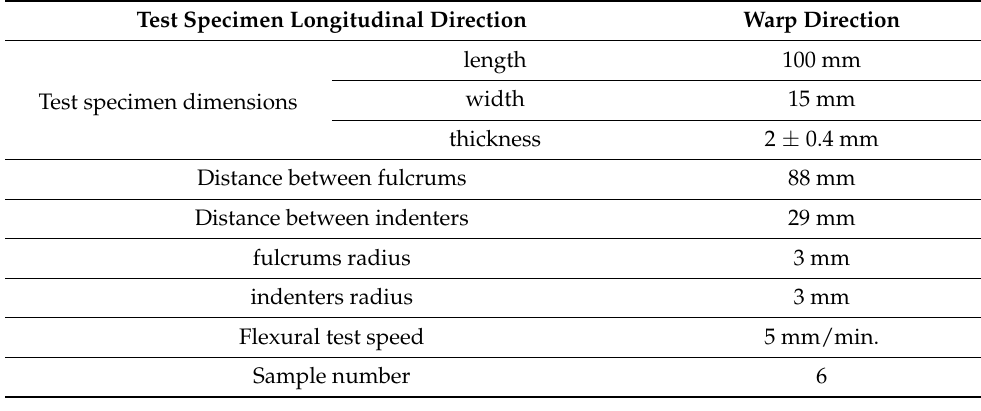
Table 6. Conditions of four-point flexural test.